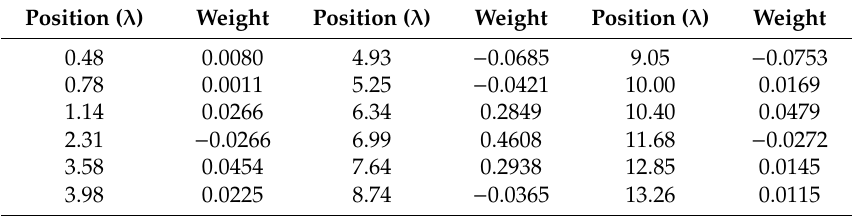
Figure 11. The flat-top BP of the sparse linear array. Table 3. Positions and weight values of the sparse linear array with flat-top BP.